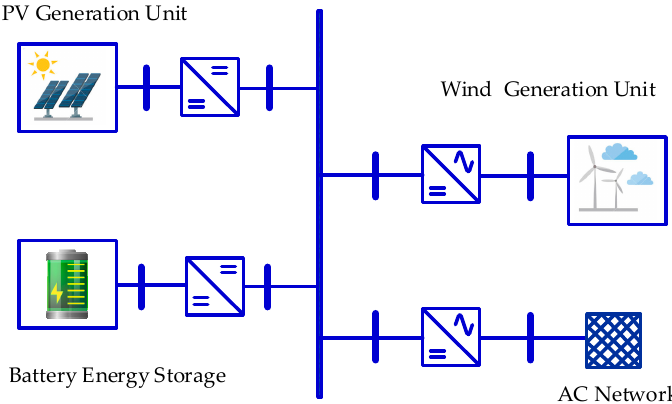
Figure 1. A typical DC microgrid integrating renewable sources.